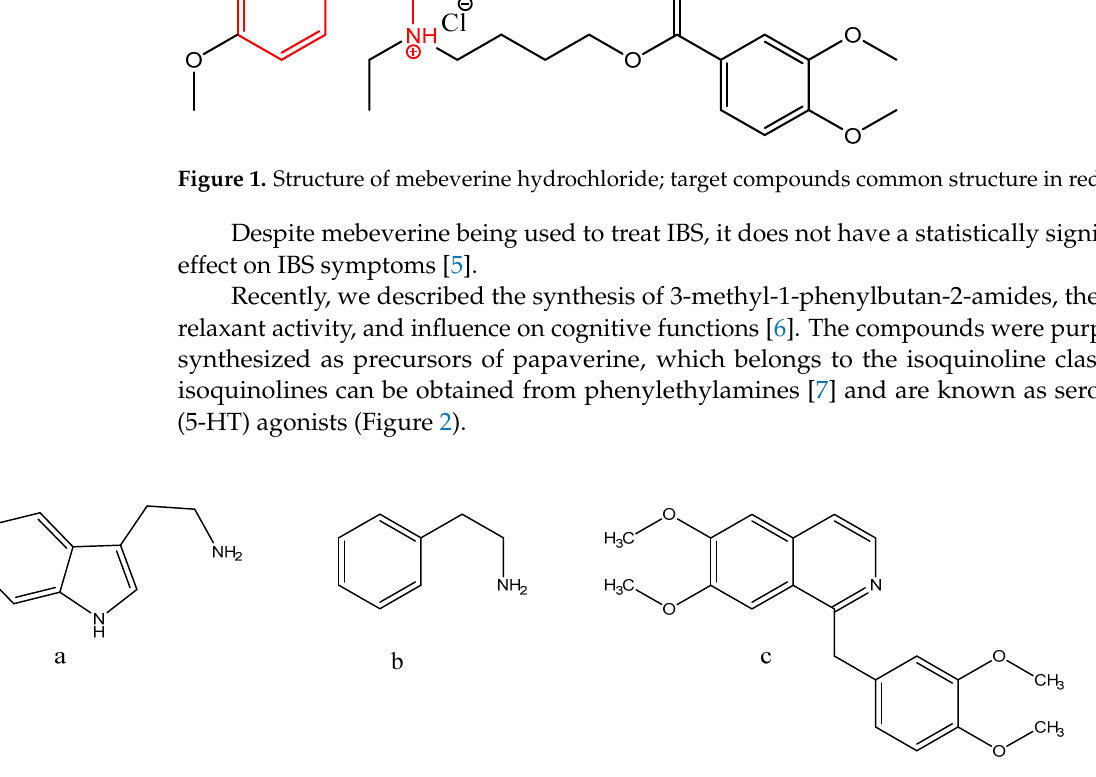
Figure 1. Structure of mebeverine hydrochloride; target compounds common structure in red.